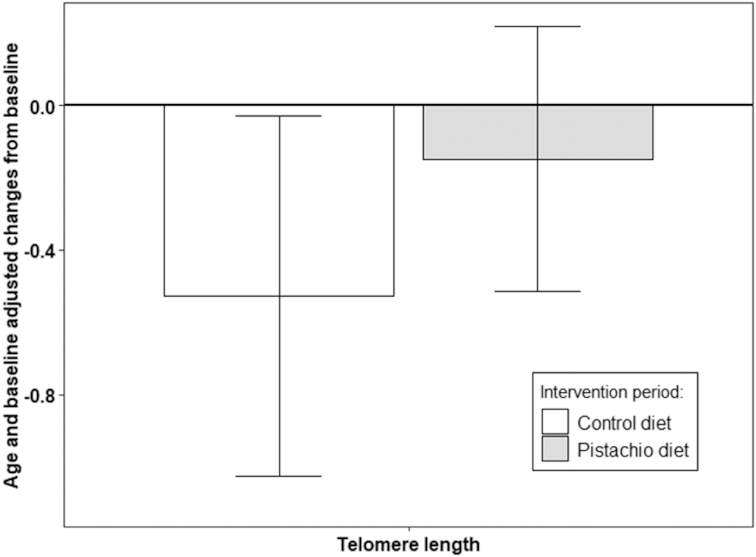
Multivariable-adjusted differences (95% CI) in changes in TL z score after the intervention period, adjusted by age and baseline TL. There was no significant difference between the changes. n = 49, limited to the first intervention period due to carryover effect. TL, telomere length.